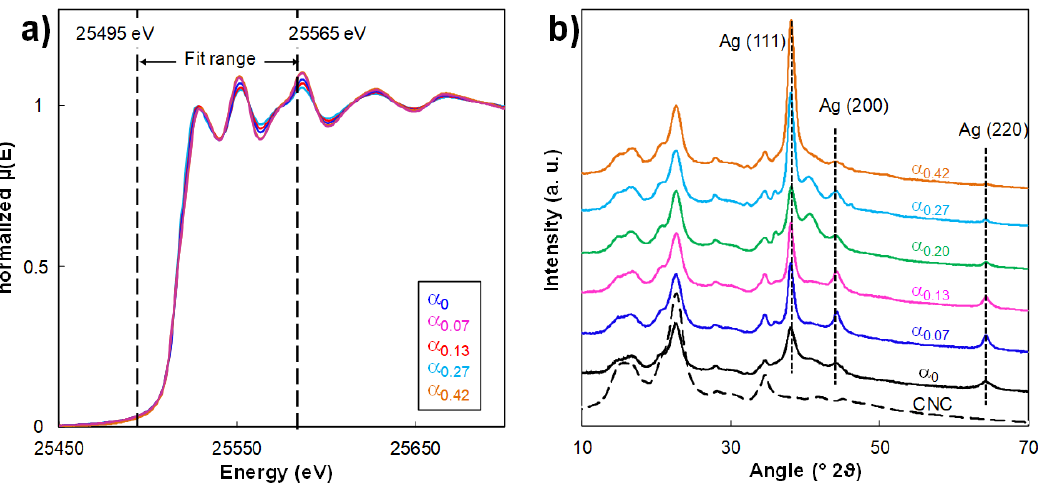
Figure 2. ( a ) X-ray absorption near-edge structure (XANES) spectra and ( b ) XRD diffractograms of CNC/AgNP hybrid suspension at 8.7 wt % AgNP mixed with different amounts of H 2 O 2 (i.e., various H 2 O 2 / AgNP mass ratios, α ).